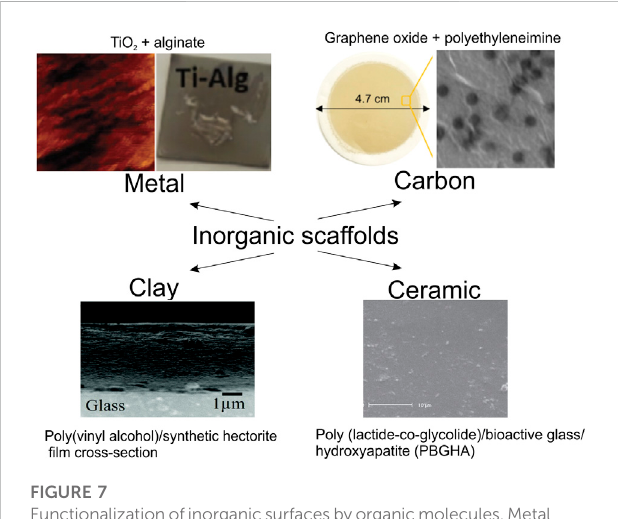
FIGURE 7 Functionalizationofinorganicsurfacesbyorganicmolecules.Metal (AFM images of TiO 2 coated by alginate hydrogel coatings reproduced from (Muderrisoglu et al., 2018) with permission Wiley-VCH), Carbon (optical and SEM images of the graphene oxide modi fi ed by polyethyleneimine fi lm; reproduced from (Nam et al., 2016) with permissionofACS),Clay(SEMimagesofthePoly(vinylalcohol)/synthetic hectorite fi lmcross-sectionwithathicknessof4.3 μ m(Teepakakornand Ogawa, 2021) with permission of the Mater. Adv.), Ceramic (SEM images of the poly (lactide-co-glycolide)/bioactive glass/hydroxyapatite (PBGHA) (Mehdikhani-Nahrkhalaji et al., 2015) reproduced from Dent. Res. J.